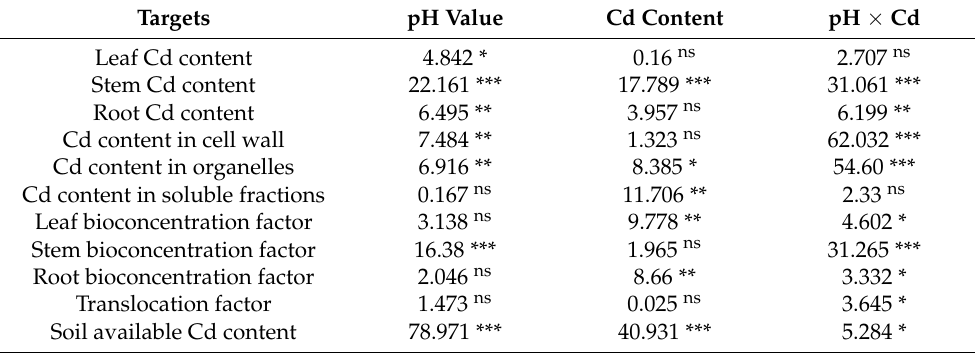
Table 3. Summary of the influence of each term (F − value) in a general linear model (GLM) testing the interacting influence of soil pH and cadmium (Cd) levels on Cd accumulation by Polygonum hydropiper